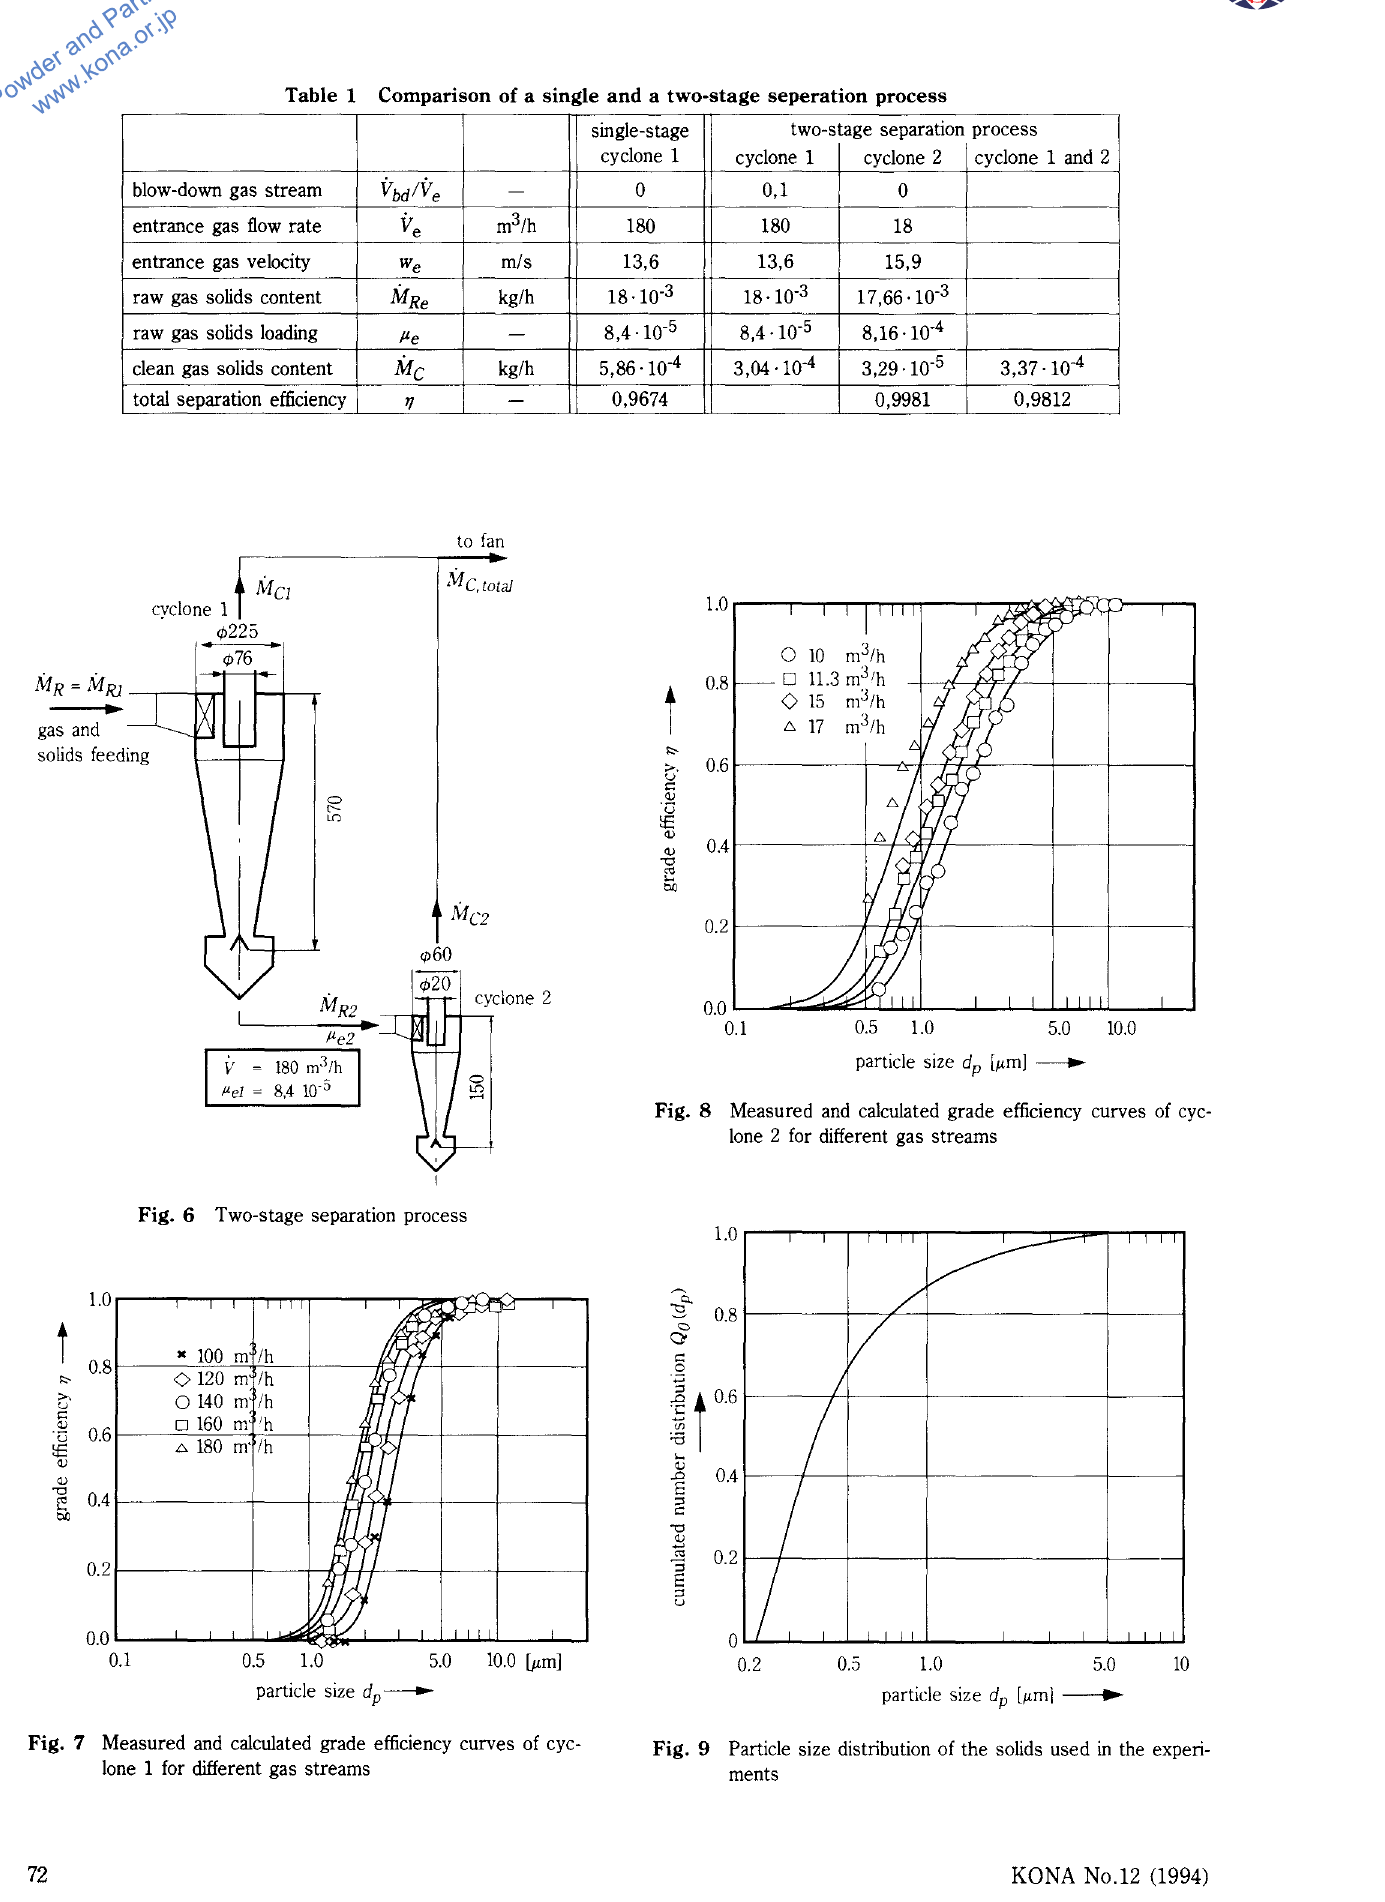
Table 1 Comparison of a single and a two-stage seperation process